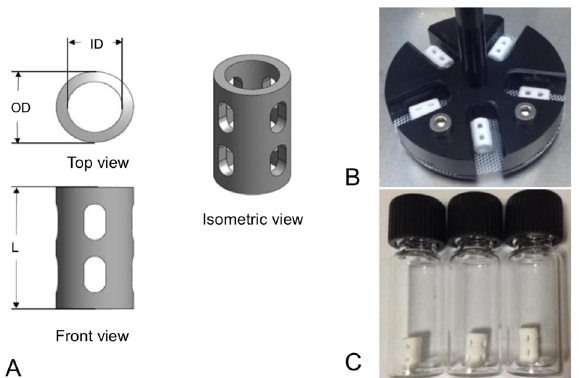
Fig. 1 PLGA/PVA scaffolds. A Schematics of a scaffold showing the top, isometric and side view. The outer diameter ( D OD ), inner diameter ( D ID ), length ( L 0 ), and total surface area ( A s ) of the printed scaffold were 3.6 mm, 2.0 mm, 6.5 mm and 126.0 mm 2 , respectively. B Scaf- folds held in a customized jig used for agitation during sonication. C Scaffolds after